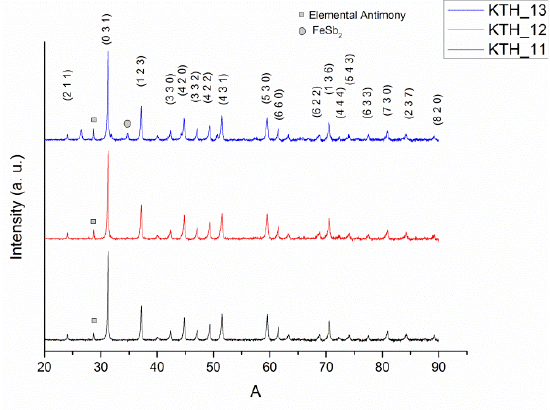
Figure 4: X-ray powder diffraction patterns of SPS compacted pellets indexed to CoSb (ICCD# 01-083-0055) . 3